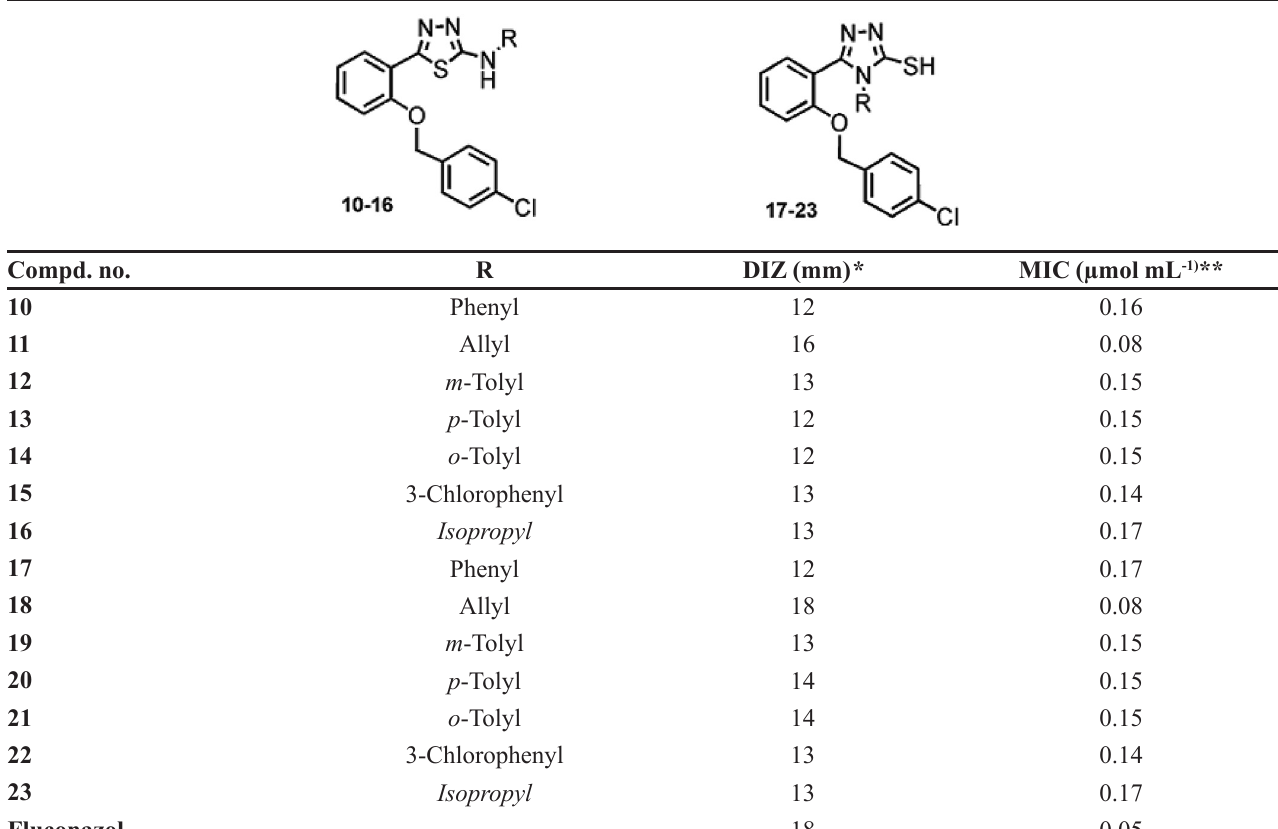
TABLE I - Anti Candida albicans activity of compounds 10-23 (100 μg mL -1 )